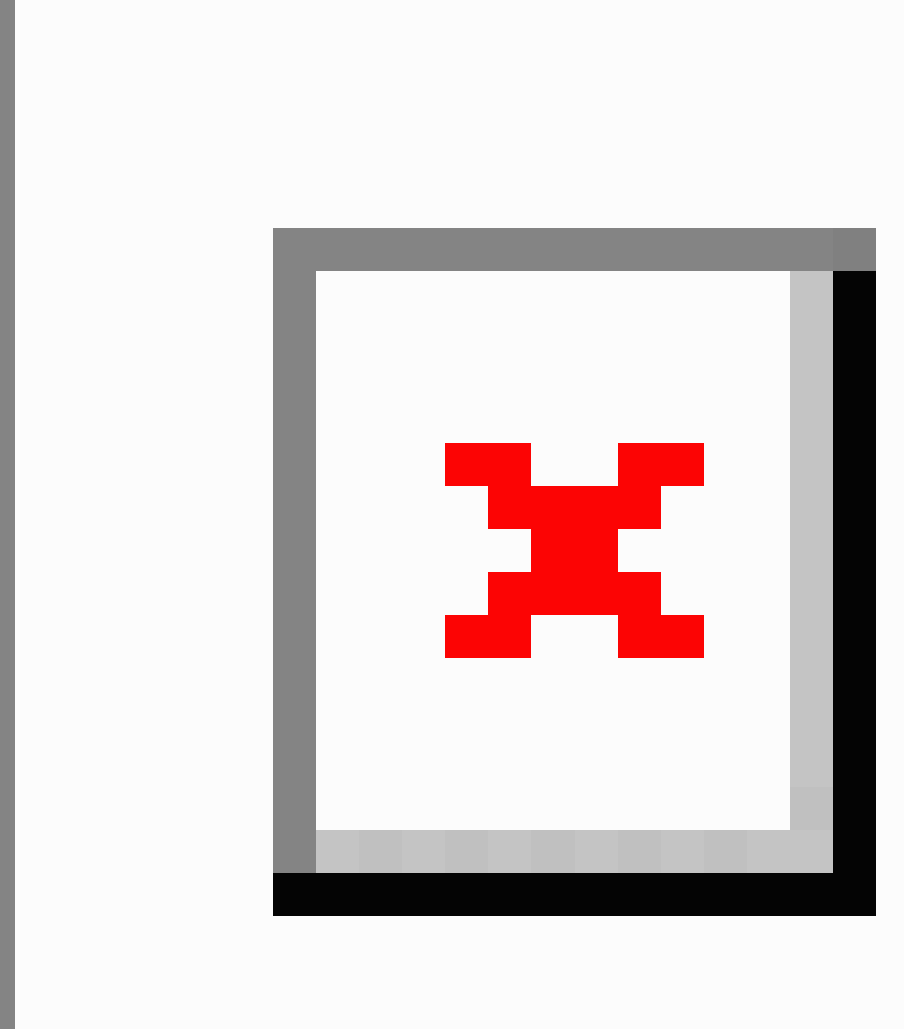
Figure 2. Discharge checklist and